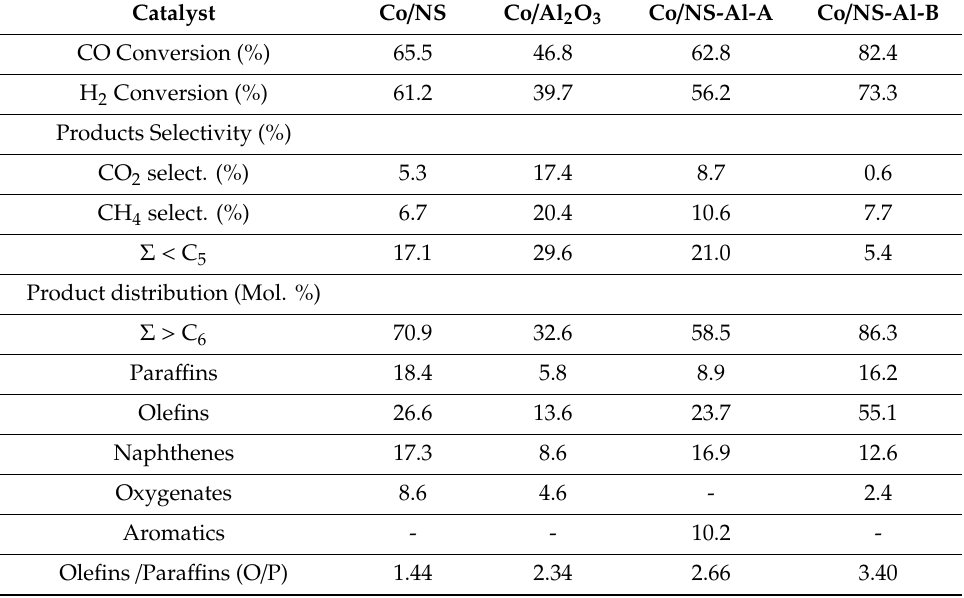
Table 2. Catalytic performance and major components of synthesized liquid FTS fuel over the calcined Co / NS, Co / Al 2 O 3 , Co / NS-Al-A and Co / NS-Al-B catalysts at 230 ◦ C, H 2 / CO = 2 and at atmospheric